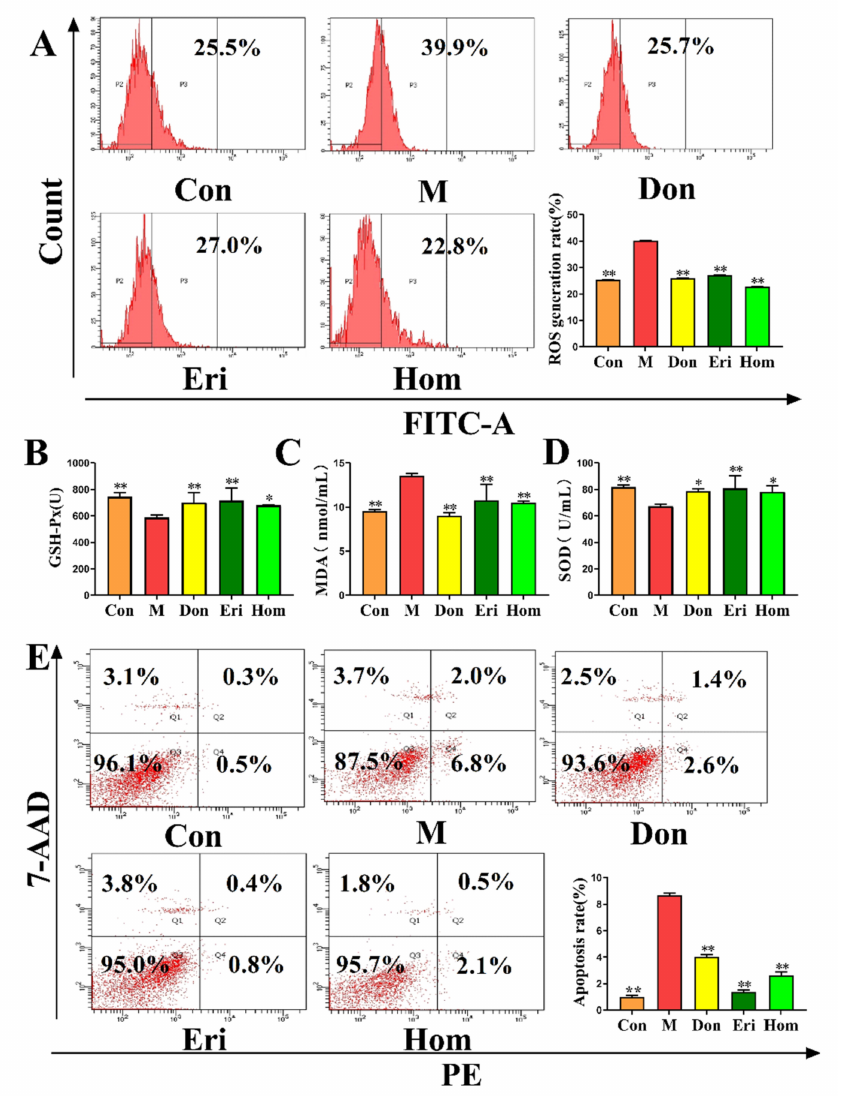
Figure 4. Eri and Hom reduce the oxidative stress in the brain tissue of mice injected with A β 25–35 . ( A ) The levels of ROS in primary mouse brain cells, and quantitative analysis of ROS. n = 3. ( B – D ) The levels of GSH-Px, MDA, and SOD in serum, n = 4. ( E ) The levels of apoptosis in primary mouse brain cells, and quantitative analysis of apoptosis, n = 3. The data were expressed as the mean ± SD. * p < 0.05, ** p < 0.01 compared with the M group. Con means the control, M means the